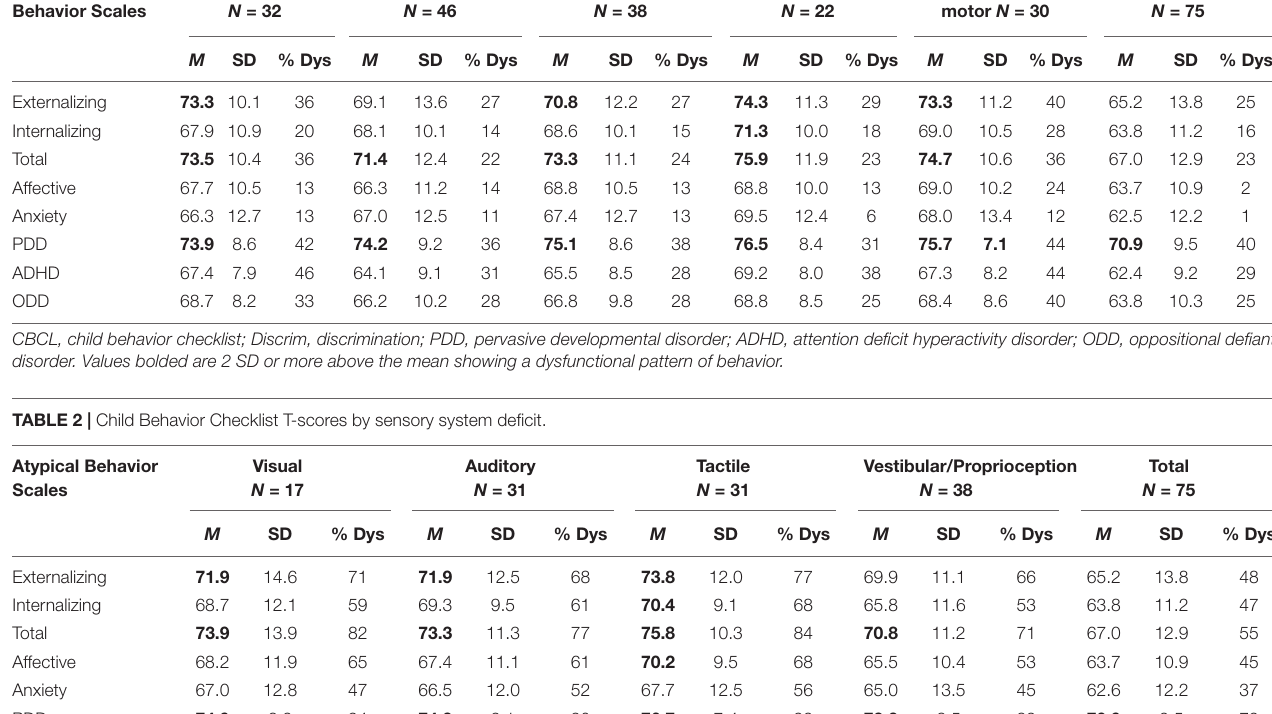
Sensory craving N = 32